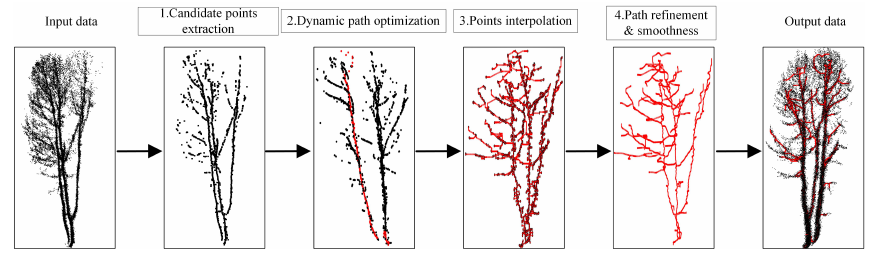
Figure 1. Flowchart of the proposed skeleton extraction